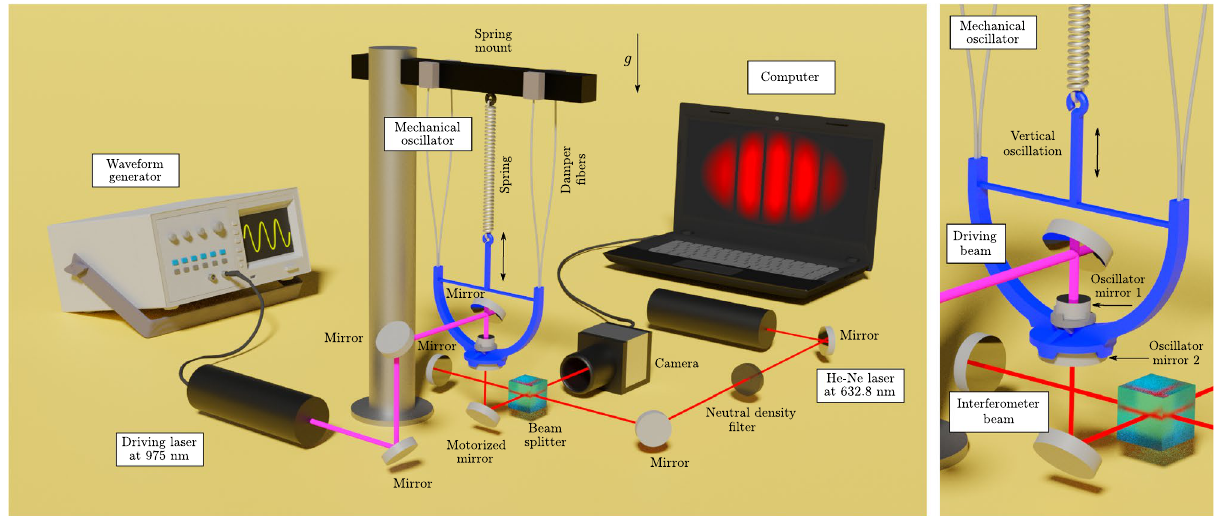
Figure 1. The experimental setup consists of three main parts shown in the left panel: the mechanical oscillator, the diode laser driving the oscillator, and the Michelson interferometer. The right panel focuses on the vertically hanging mechanical oscillator. The mechanical oscillator is driven by a modulated laser beam at 975 nm through the reflection from the highly reflective oscillator mirror 1. The nanoscale oscillation is detected through the oscillator mirror 2 by the Michelson interferometer using the He–Ne laser at 632.8 nm. The motorized mirror below the oscillator is used for the remote tuning of the interference fringe spacing, but it is not actively controlled during the measurements. The illustration includes the damper fibers that are used for increasing the damping constant of the higher damping oscillator. The apparatuses are mounted on an actively damped optical table for isolating the setup from external acoustic and seismic vibrations. The oscillator part of the setup is also protected with plastic walls not shown in this illustration. A more complete description of the experiment is presented in the “Methods” section. (Image created by using Blender 2.8, https ://www.blend er.org/, and Inkscape 0.92, https ://inksc